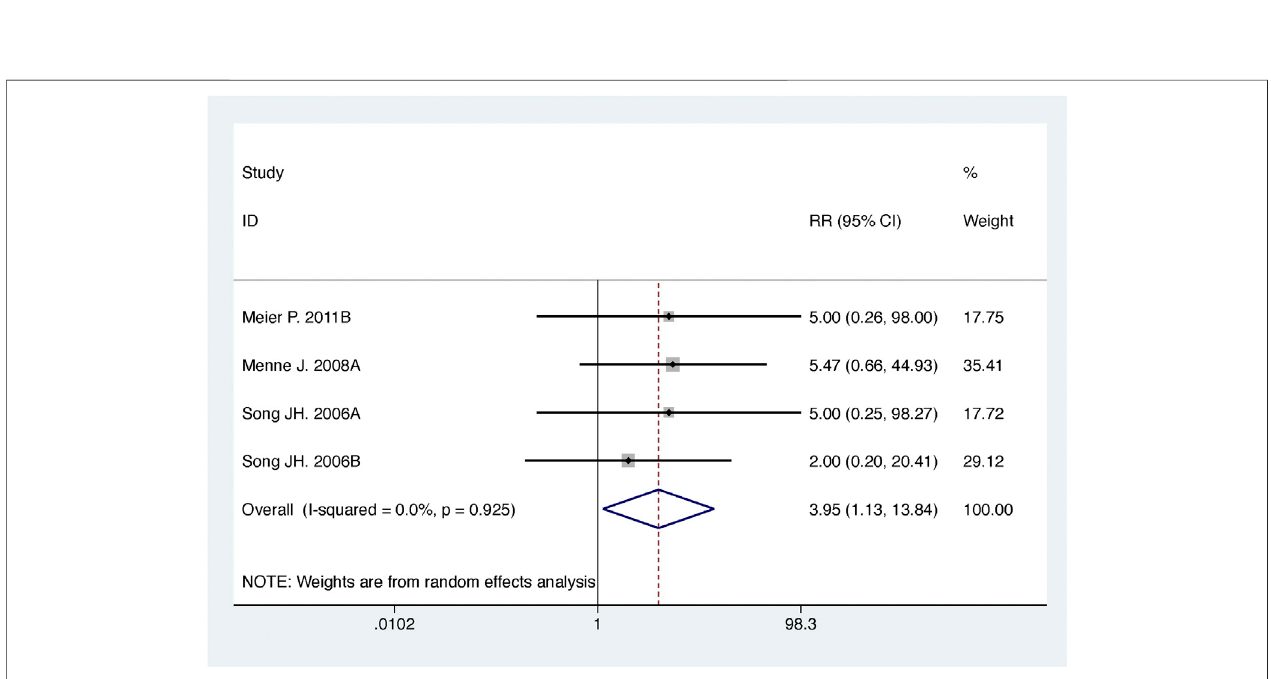
FIGURE 13 | Comparison of ACEI in combination with ARB vs. high-dose ACEI or ARB for development of hypotension.